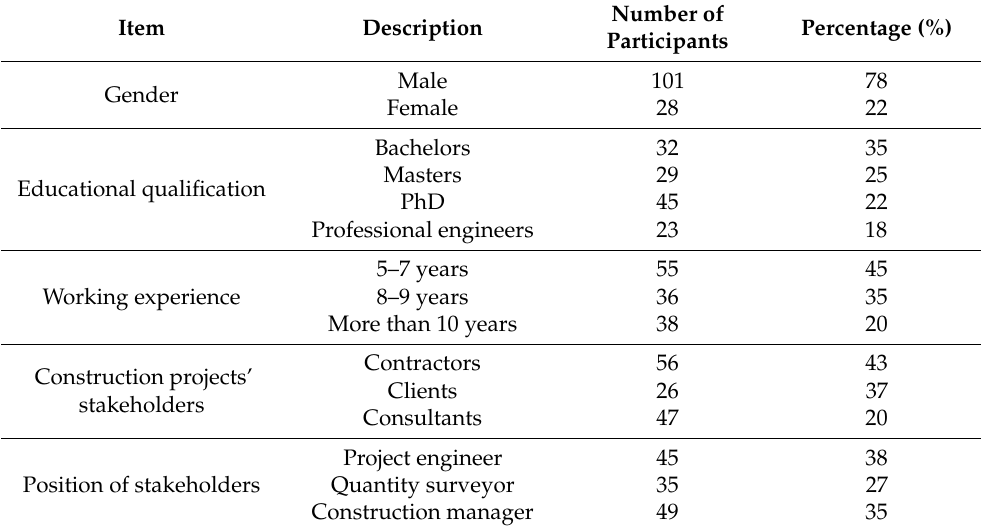
Table 2. Distribution of